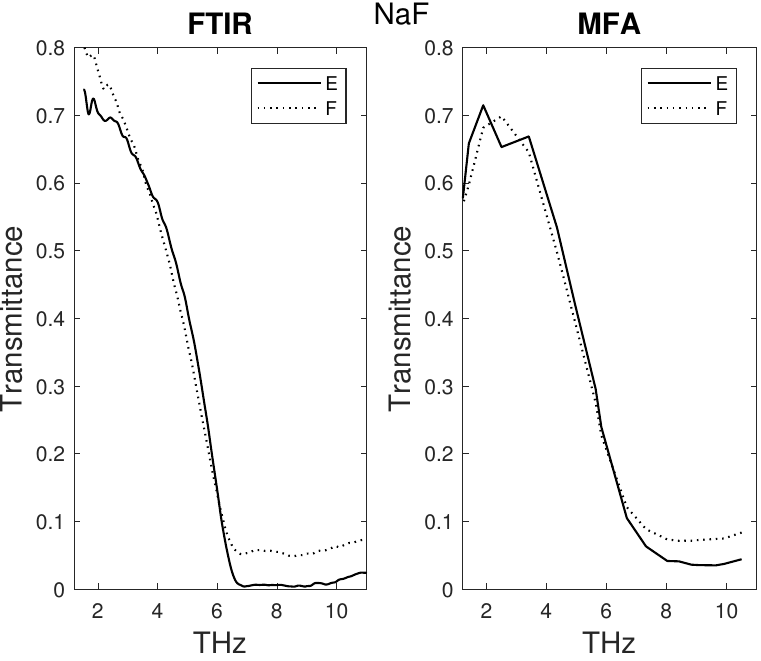
Figure 5. Comparison on two samples E and F of NaF using FTIR ( left ) or filter ( right